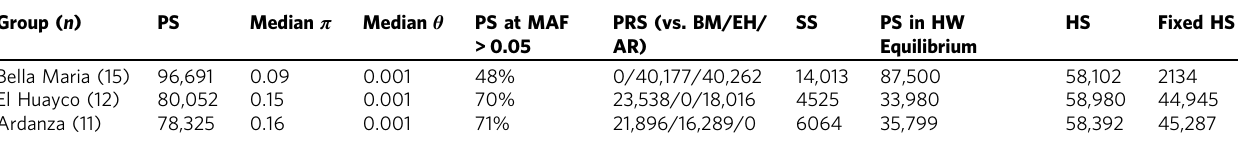
PRS (vs. BM/EH/ SS PS in HW HS Fixed HS > 0.05 AR) Equilibrium